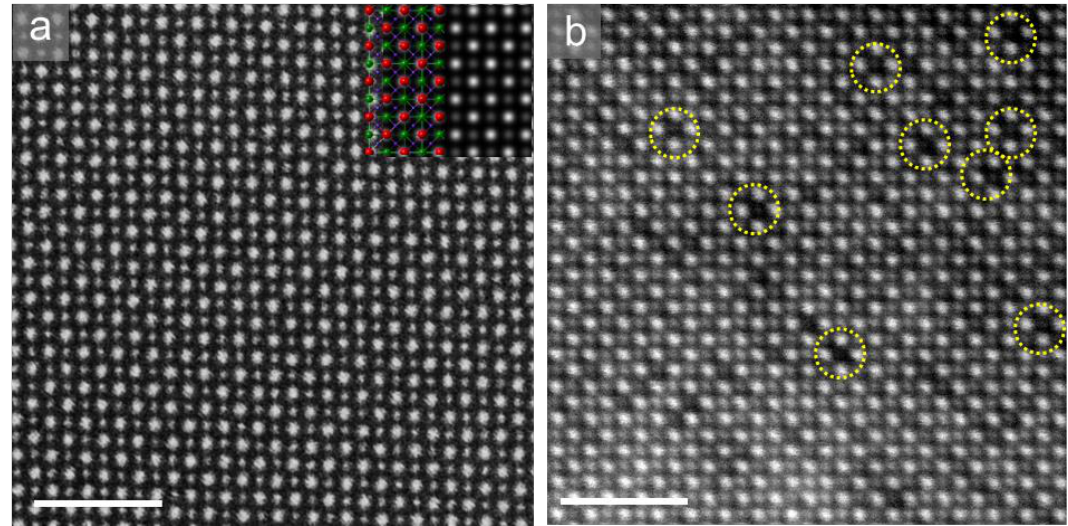
Figure 3. Atomically resolved HAADF images of pristine ( a ) and 1300 °C-quenched ( b ) LLNO electrolytes along [001] direction. Scale bars: 2 nm. La vacancies are not present in pristine non-quenched samples, where the inset simulated HAADF image in ( a ) agrees well with the experimental image. Dark atomic columns correspond to La in the inset of ( a ), as indicated by the green atoms (La) in the superposed structure model. Vast La vacancies appear in the 1300 °C-quenched sample, as highlighted by the yellow circles in ( b ).